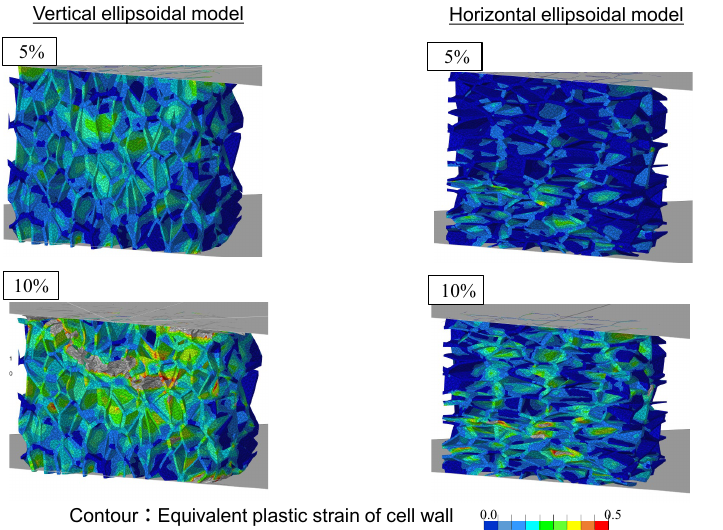
Fig.7. Deformation behavior of VE and HE cell models at 5% and10%